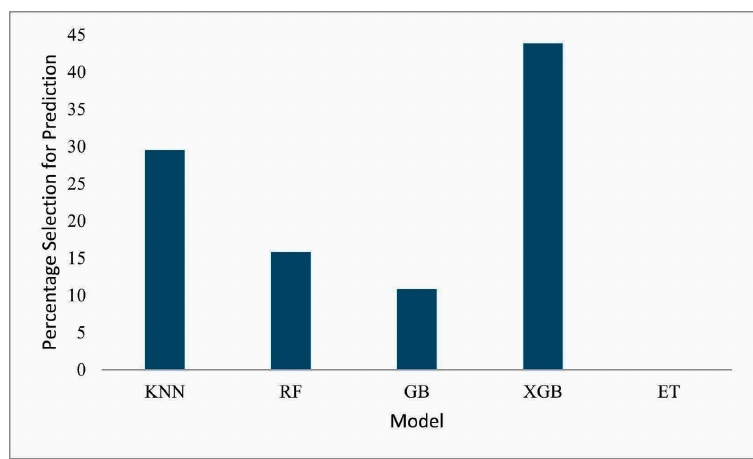
Figure 7. Coefficient of determination of models from dataset 1.